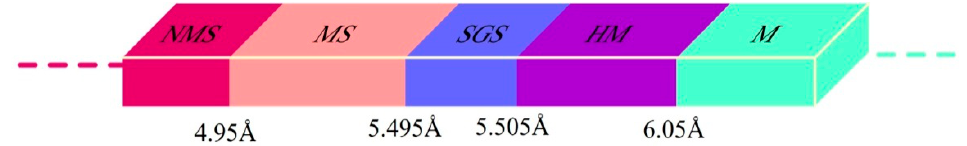
Figure 9. Physical transitions under uniformly strained lattice constants.